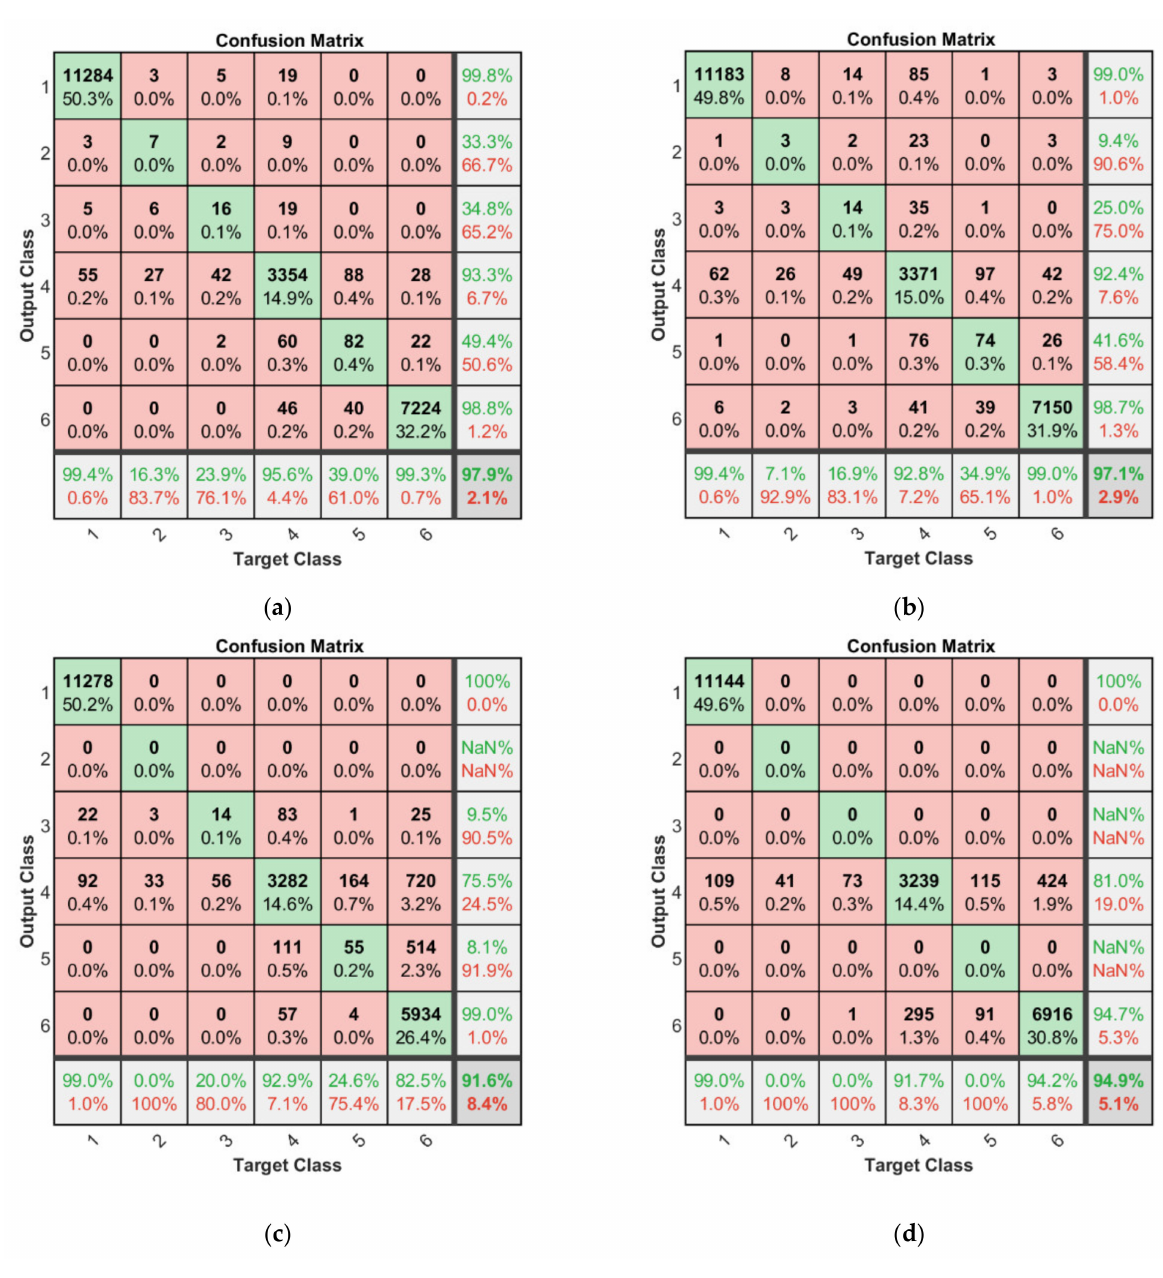
Figure 10. Confusion matrix of ( a ) the decision tree classification mode, ( b ) the K-nearest neighbour classification model, ( c ) the naive bayes classifier and ( d ) the Support Vector Machine classification model. Green boxes represent the successes on the 5 different classifications. Red boxes represent the committed mistakes. White boxes gather the success-mistake rates at each